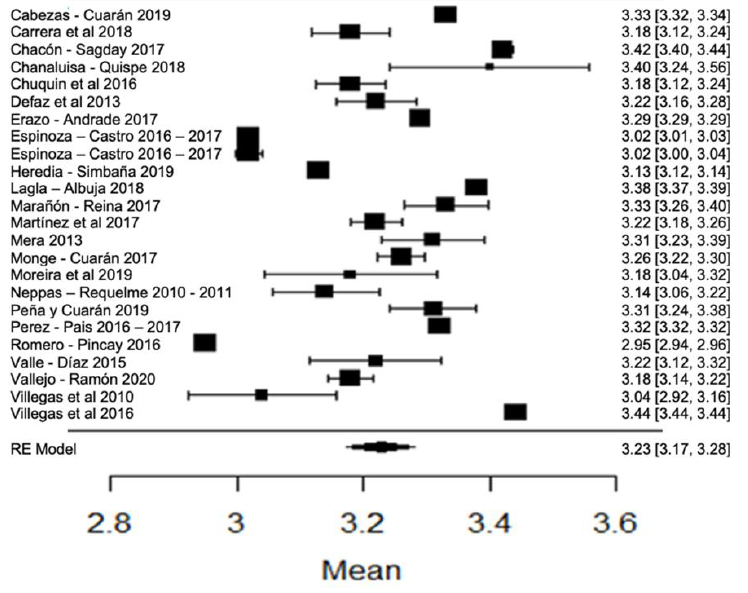
Figure 9. Forest plot of protein [14,16–18,21,23,24,26,28,30,33,35,38,39,42,44,51,53,57,60,61,63,64,76,77,79,80].